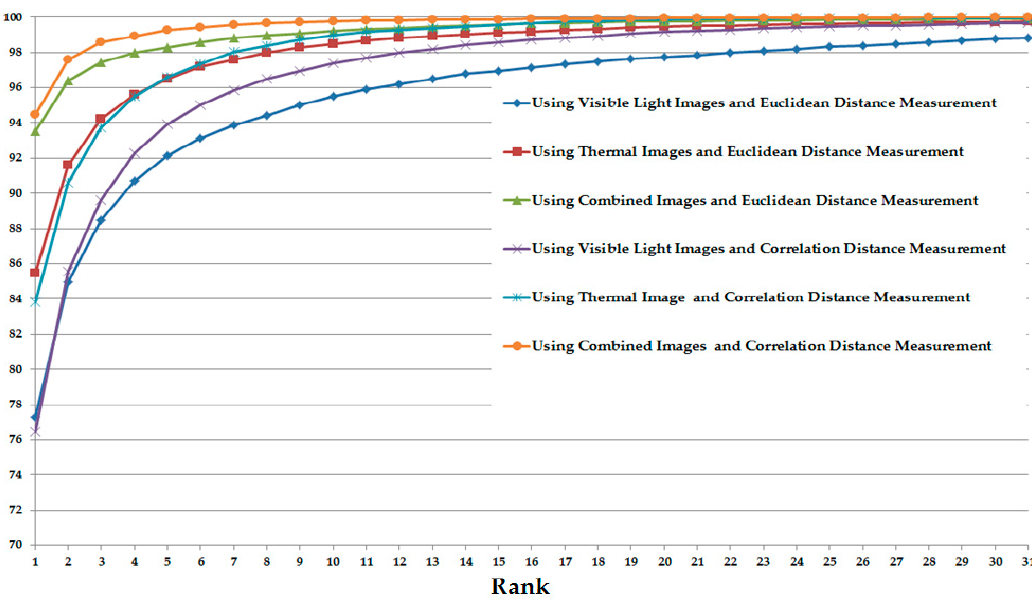
Figure 18. CMC curves of the identification systems that use the torso part for the identification problem.